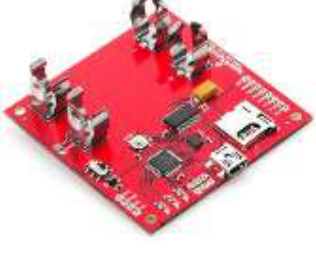
Fig. 1. ADXL345 evaluation